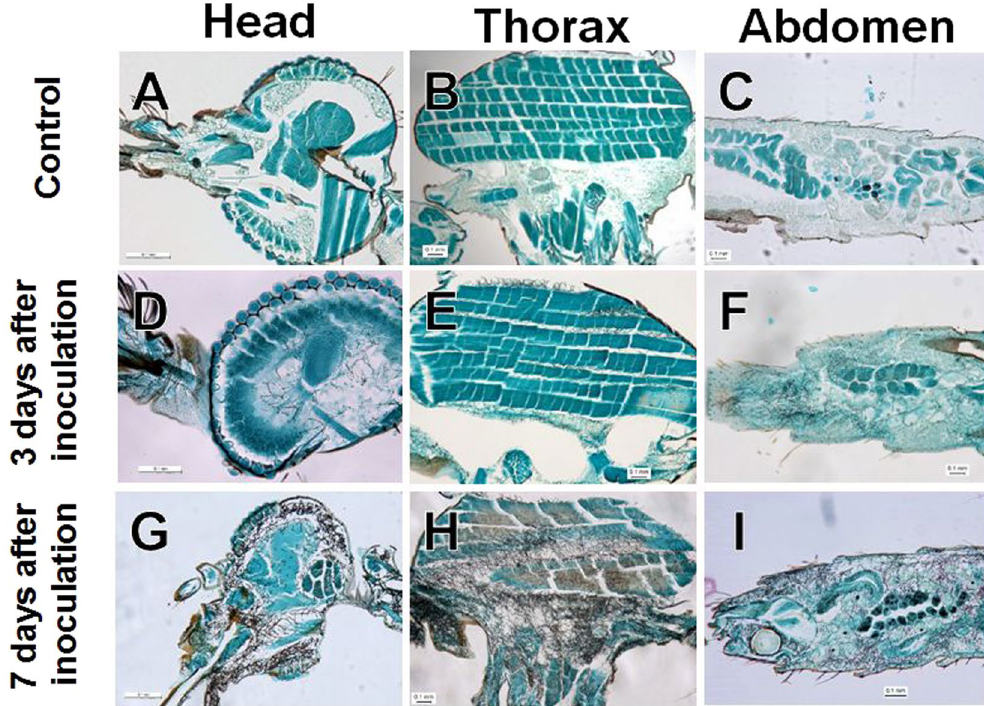
Figure 2. Images of uninfected and infected mosquito body parts. ( A – C ) Control: Anopheles stephensi female adult without fungal infection. ( D – I ) Fungal infection of body parts in An. stephensi female adults at ( D – F ) an early stage of infection (3 days after inoculation) and ( G – I ) a later stage of infection (7 days after inoculation). ( A , D and G ) head; ( B , E and H ) thorax; and ( C , F and I ) abdomen. Mosquito tissues and organs were stained with fast green, and fungal propagules were specifically stained (in black) with Grocott